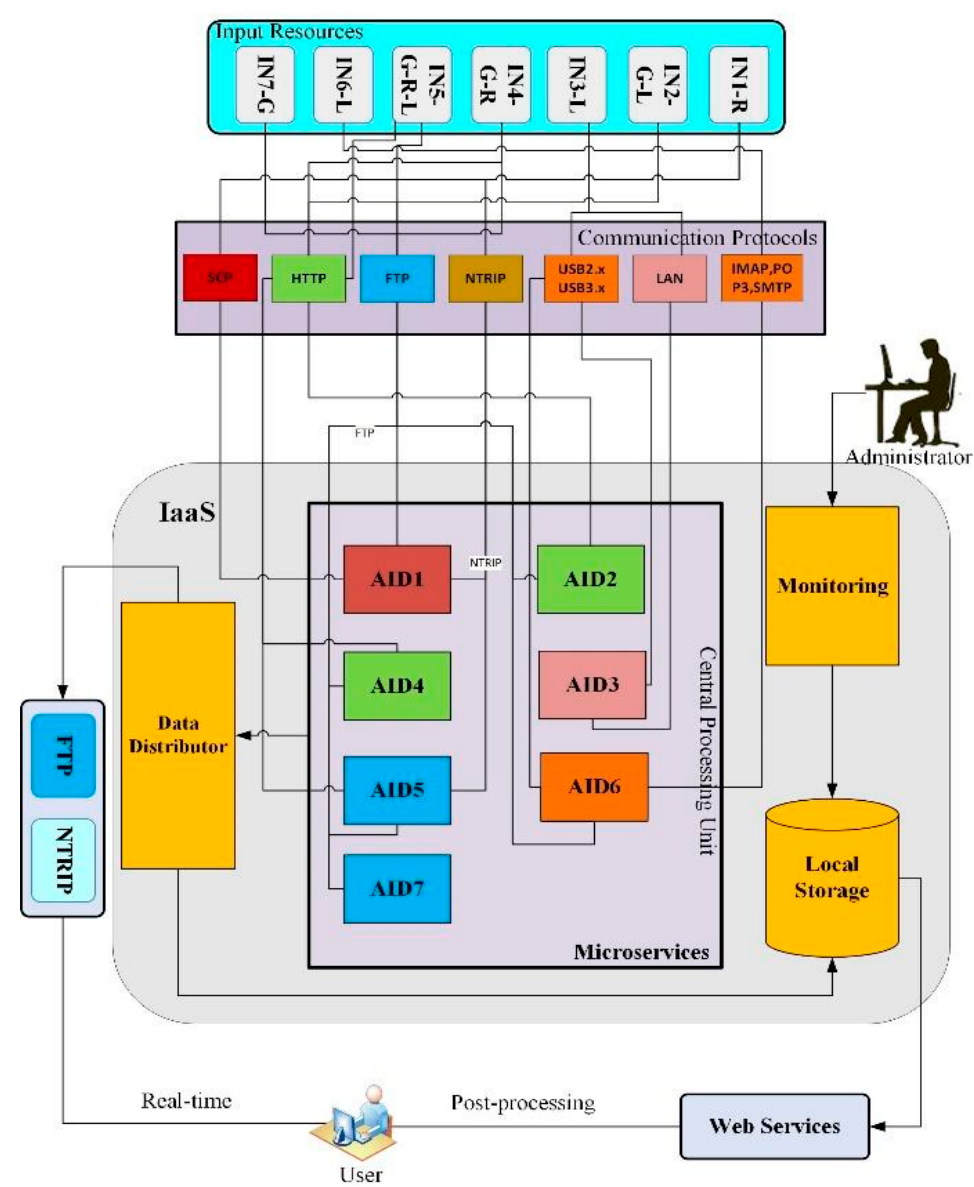
Figure 2. Block diagram of the designed information and communication technology (ICT) technical architecture .